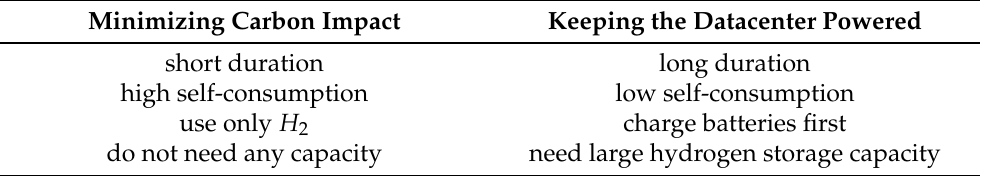
Table 1. Contradictory consequences of carbon impact minimization and datacenter